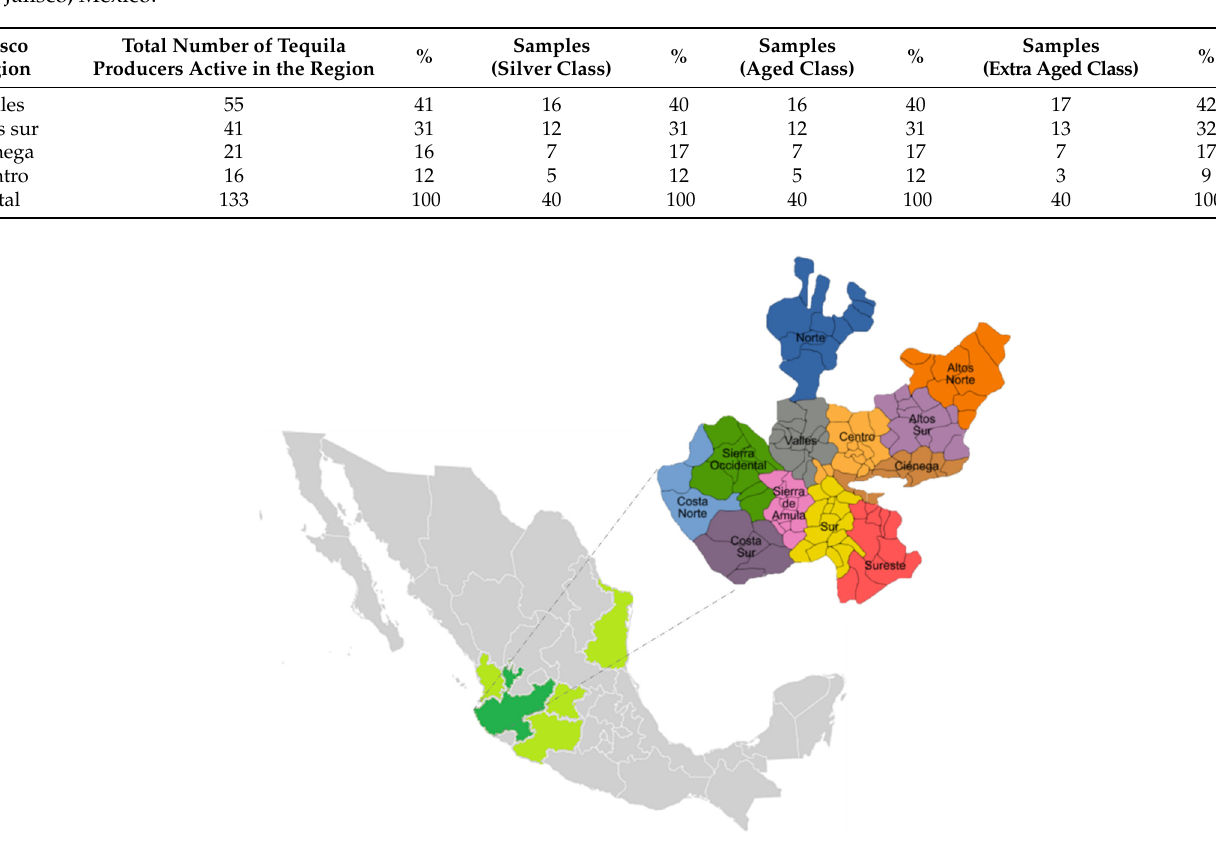
Figure 5. Map of Mexico states that conform to tequila’s appellation in green color: Nayarit (8 municipalities), Jalisco (125 municipalities), Michoacán (30 municipalities), Guanajuato (7 municipalities) and Tamaulipas (11 municipalities). Highlighting in the dark green the state of Jalisco with its division by geographical regions.